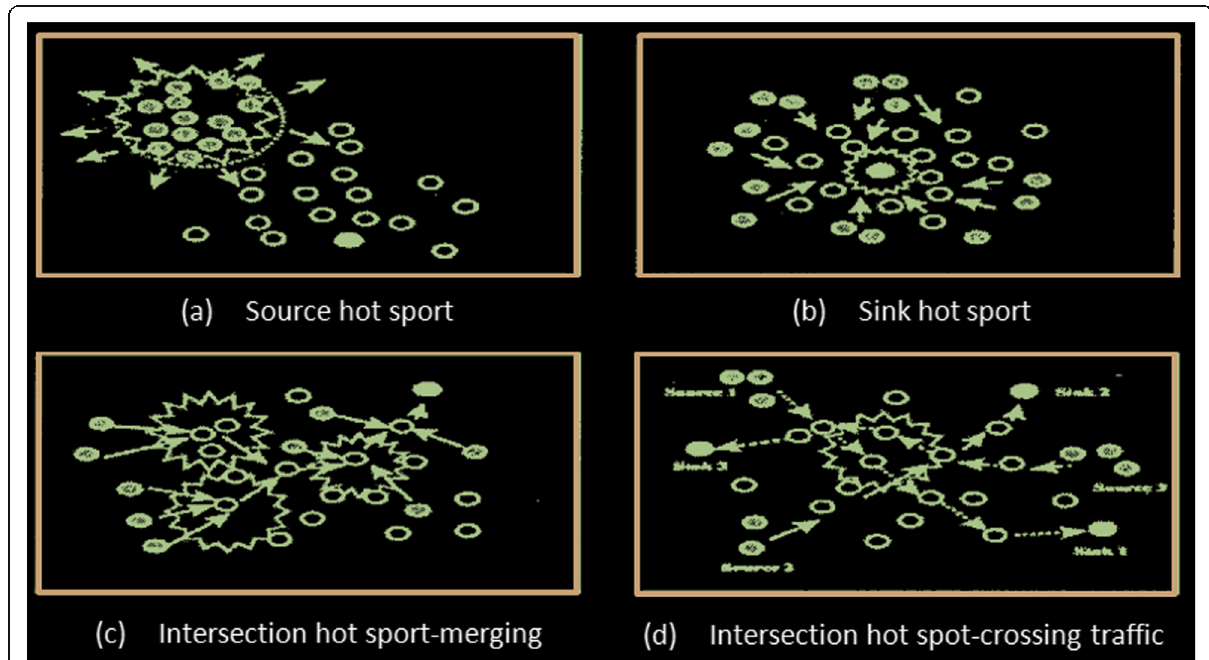
Fig. 3 Three "hot spots" area